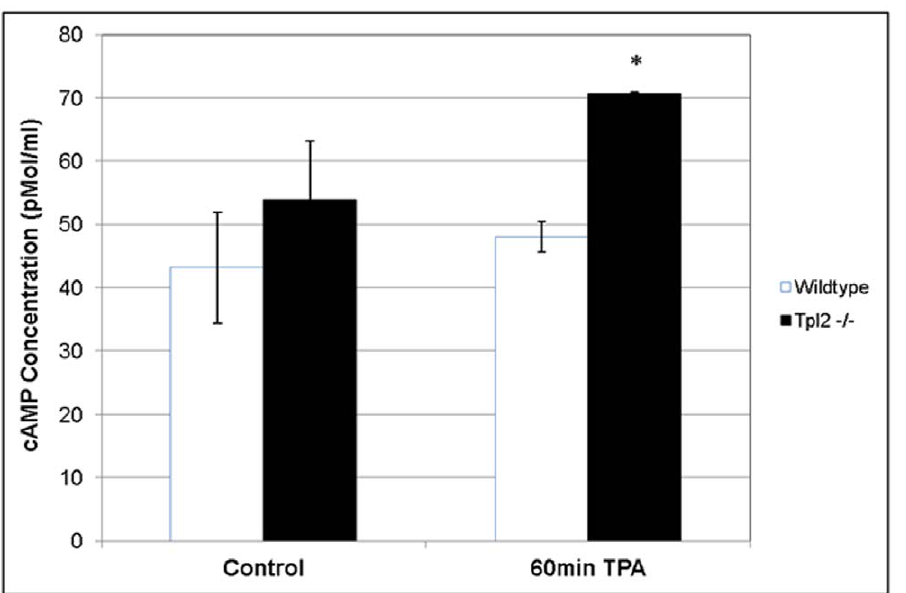
Figure 5. cAMP production is higher in keratinocytes from Tpl2 2 / 2 mice. Wildtype or Tpl2 2 / 2 keratinocytes received DMSO only (control) or TPA (10 ng/ml). Lysates were collected after 60 minutes of TPA treatment. cAMP concentration was determined using a cAMP immunoassay kit. Significant differences were found between genotypes following TPA treatment (p , 0.002).